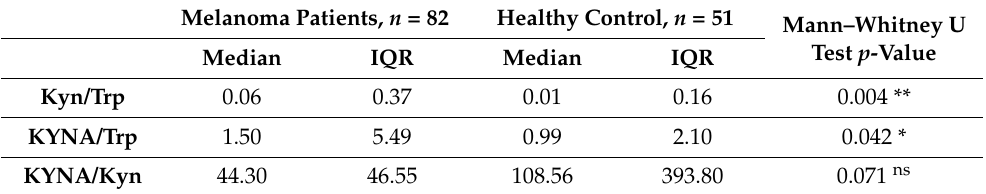
Table 3. Urinary Kyn/Trp, KYNA/Trp, and KYNA/Kyn ratios characteristic of the kynurenine pathway. Melanoma Patients, n = 82 Healthy Control, n = 51 Mann–Whitney